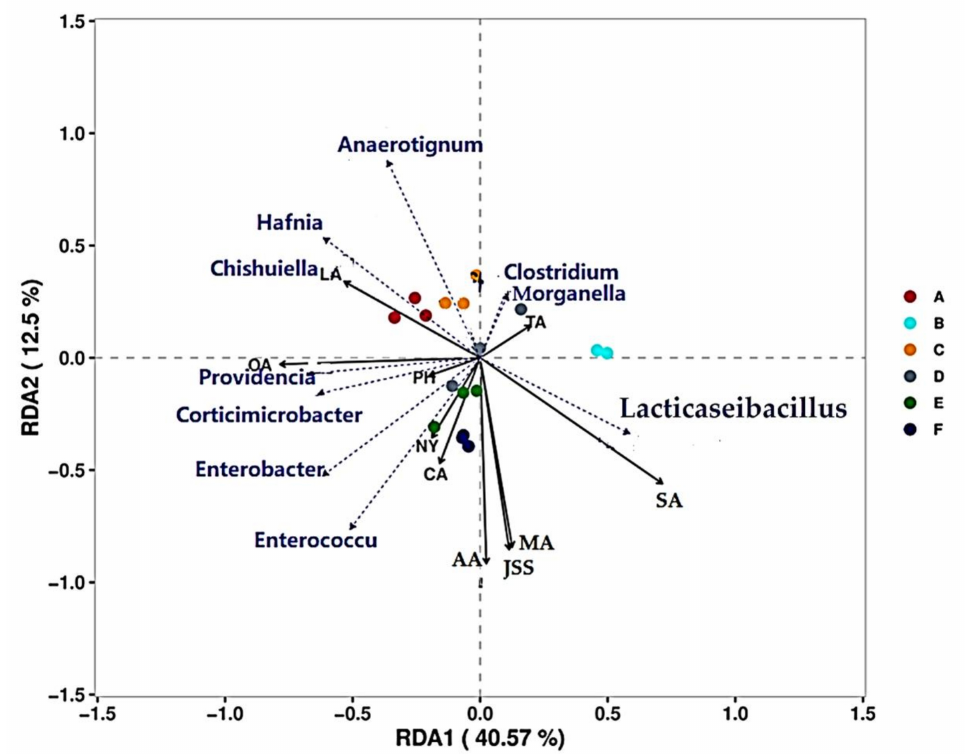
Figure 6. Correlation between RDA (OTU > 0.1%) and physicochemical index for bacterial genera. (A–F) represent samples during traditional tomato sour soup (CTN) fermentation. PH, TA—total acid content; NY—nitrite content; JSS—tartaric acid content; MA—malic acid content; LA—lactic acid con- tent; AA—acetic acid content; CA—citric acid content; SA—succinic acid content; OA—oxalic